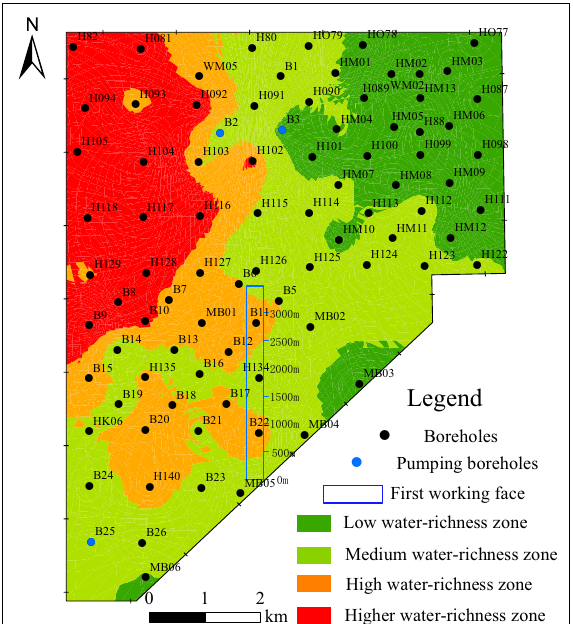
Figure 9. Zoning map of water-richness for roof water-bearing aquifers.